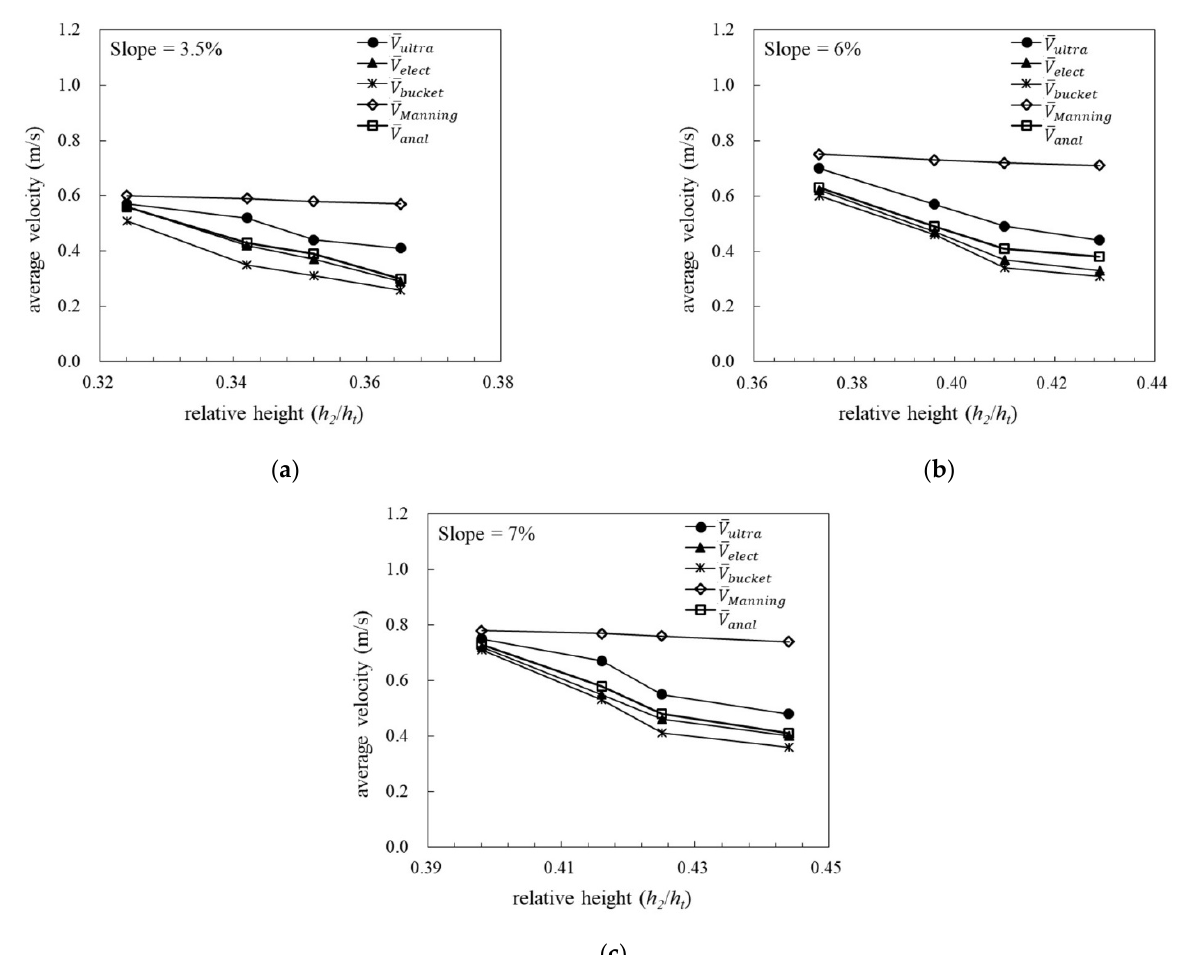
Figure 4. Average flow velocities at different relative heights for Bermuda grass with bed slopes of ( a ) 3.5%, ( b ) 6%, and ( c ) 7%.